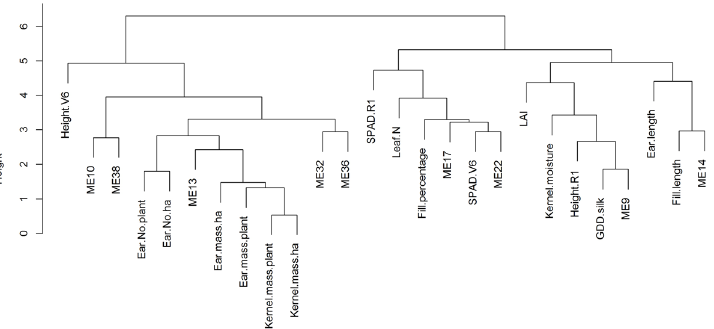
Fig 2. Hierarchical clustering of phenotypic traits and module eigengene values (ME). Phenotypic traits were labeled as ‘ Height.V6 ’ , height at V6; ‘ Ear.No.plant ’ , number of ears per plant; ‘ Ear.No.ha ’ , number of ears per hectare; ‘ Kernel.mass.plant ’ , kernel mass per plant; ‘ Kernel.mass.ha ’ , kernel mass per hectare; ‘ SPAD.R1 ’ , SPAD at R1; ‘ Leaf.N ’ , leaf nitrogen; ‘ Fill.percentage ’ , fill percentage; ‘ SPAD.V6 ’ , SPAD at V6; ‘ LAI ’ , leaf area index; ‘ Kernel.moisture ’ , kernel moisture; ‘ Height.R1 ’ , height at R1; ‘ GDD.silk ’ , GDD to silk; ‘ Ear.length ’ , ear length; ‘ Fill.length ’ , fill length.